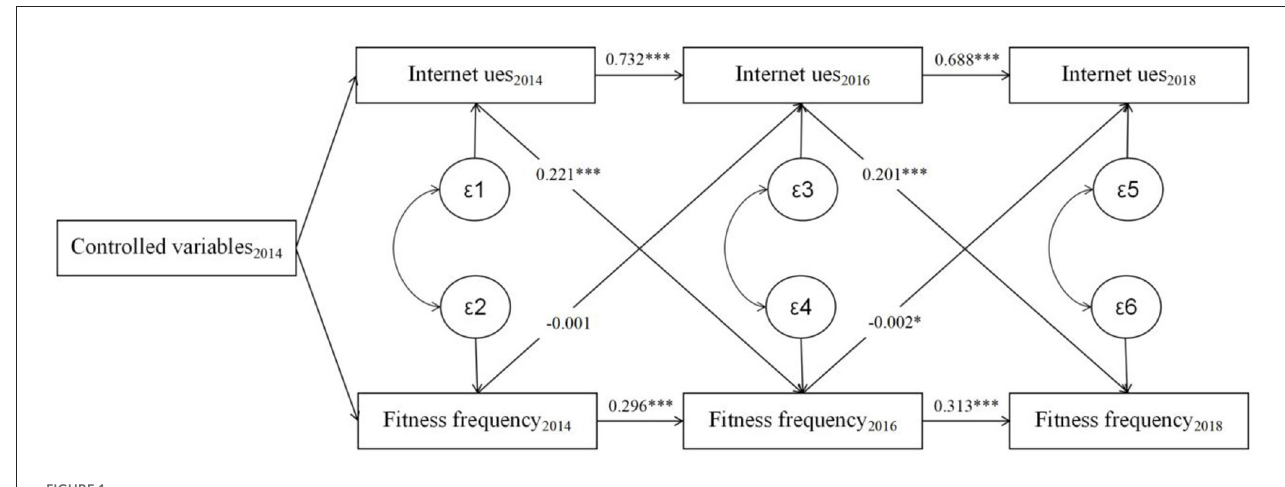
( β t − 2 = 0.008, p > 0.1). However, the first and second measures of fitness time significantly and negatively predict the second and third measures of Internet duration ( β t − 1 = − 0.107, p < 0.001; β t − 2 = − 0.133, p < 0.001), suggesting that the decrease in fitness time is responsible for the increase in Internet duration; in other words, the increase in physical fitness time significantly reduces Internet